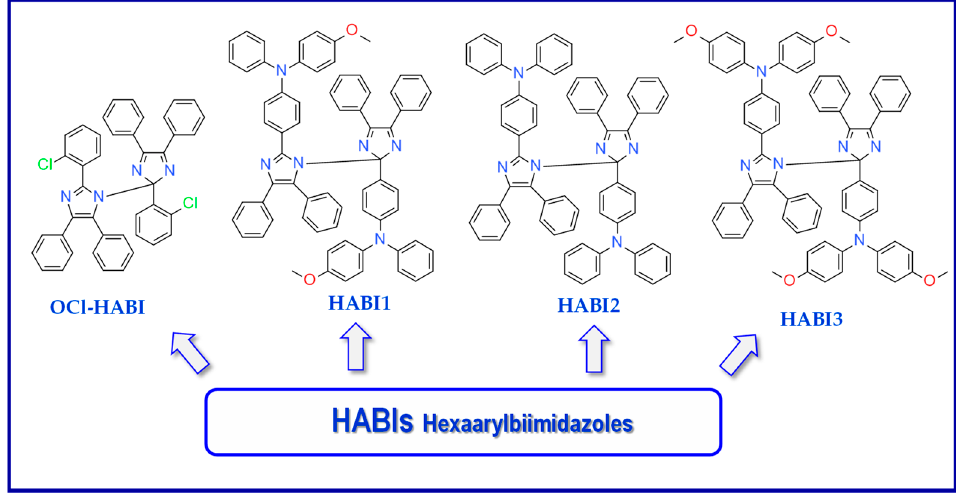
Figure 14. Structures of different hexaarylbiimidazole (HABI) derivatives.